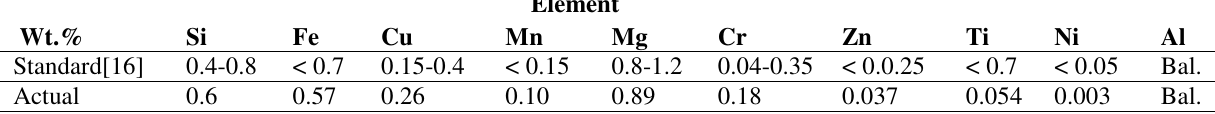
Table 1, Standard and actual chemical compositions of aluminum alloy 6061-T6